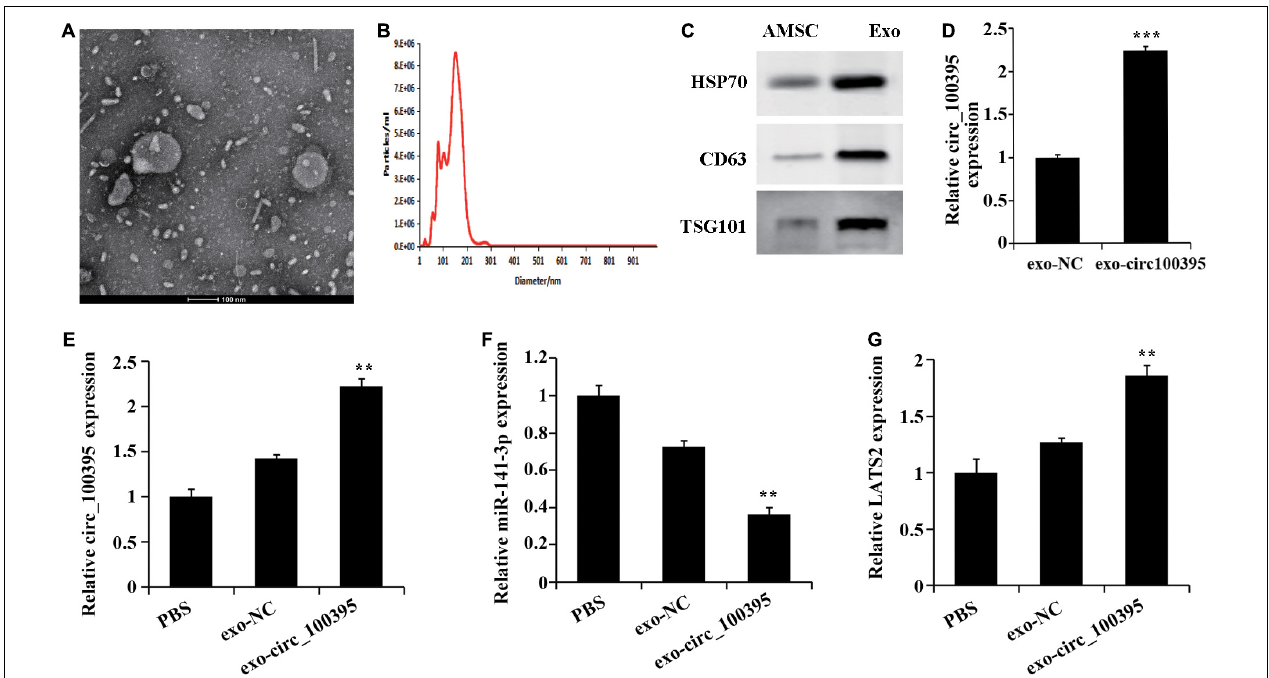
FIGURE 5 | AMSCs exosomes transport circ_100395 into NSCLC cells. (A) Morphology of AMSC observed using transmission electron microscopy (100 nm); (B) AMSC size analysed using nanoparticle tracking**; (C) Expressed HSP70, CD63, and TSG101 detected via western blot; (D) Exosomes in circ_100395 analysed via qRT-PCR; (E–G) Expressed circ_100395, miR-141-3p, LATS2 in H1650 cells post exo-NC or exo-circ_100395 treatment analysed via qRT-PCR. ** p < 0.01 and *** p < 0.001 vs exo-NC